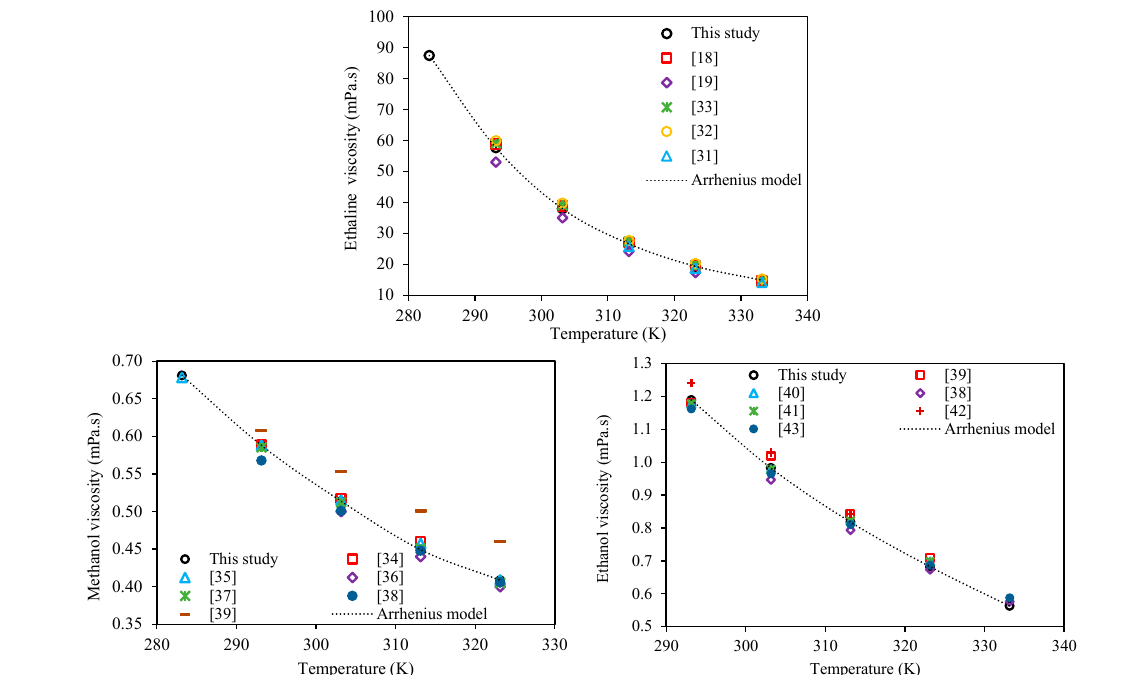
Figure 1. Comparison of the behaviors of the measured viscosities with respect to temperature at atmospheric pressure for Ethaline (1 ChCl:2 ethylene glycol), methanol, and ethanol in this study and literature values (dotted lines are the Arrhenius models, Equation (1)). Table 3. Experimental viscosities of Ethaline + methanol/ethanol at the investigated temperatures and at a pressure of 100 kPa a,b,c .